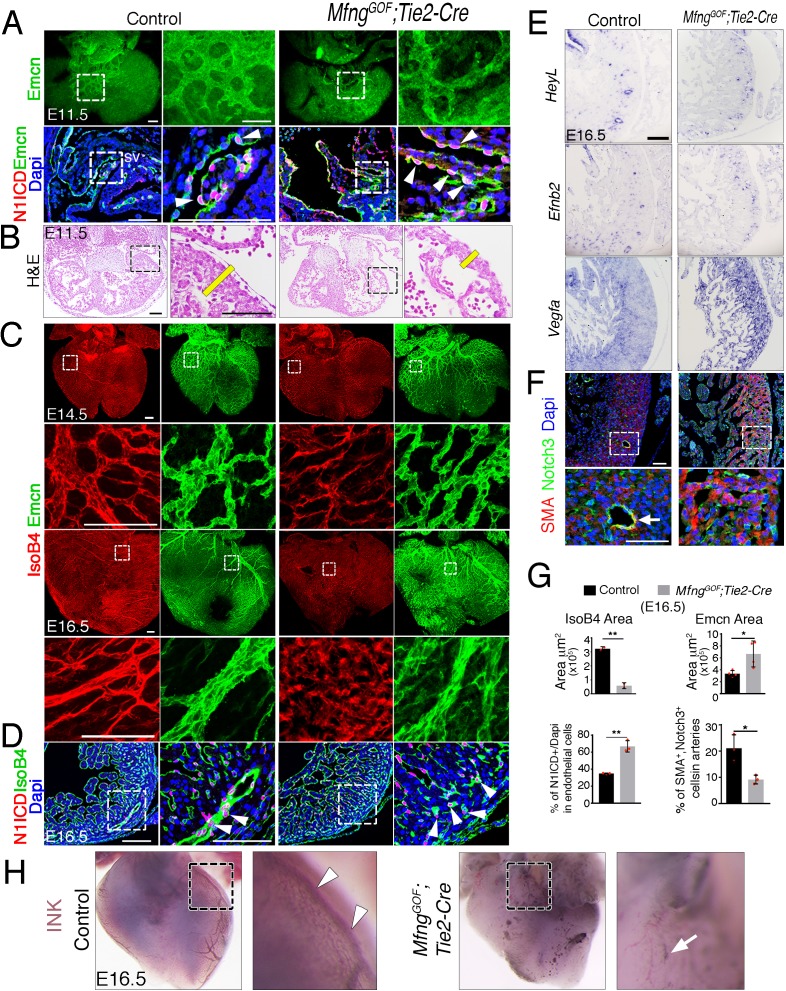
Forced Mfng expression disrupts arterio-venous differentiation and arterial endothelial integrity.(A) Top, Dorsal view of whole-mount immunochemistry for Emcn (labeling SV endothelium, green) in E11.5 control and MfngGOF;Tie2-Cre hearts. Bottom, Immunohistochemistry for N1ICD (red) and Emcn (green) on E11.5 control and MfngGOF;Tie2-Cre heart sections. Dapi counterstain (blue). Arrowheads indicate N1ICD-stained nuclei. sv, sinus venosus. Scale bars, 100 μm. (B) H & E staining of E11.5 control and MfngGOF;Tie2-Cre heart sectionas showing reduced compact myocardium (CM) thickness in transgenic embryo (yellow bar). Scale bars, 100 μm. (C) Dorsal view of whole-mount immunohistochemistry for IsoB4 (red), labeling arteries and Emcn (green), labeling veins and capillaries, in E14.5 and E16.5 control and MfngGOF;Tie2-Cre hearts. Scale bars, 100 μm. (D) Immunohistochemistry for N1ICD (red) and IsoB4 (green) on E16.5 WT and MfngGOF;Tie2-Cre heart sections. Arrowheads indicate N1ICD-stained nuclei. Scale bars, 100 μm. (E) ISH of HeyL, Efnb2, and Vegfa on E16.5 control and MfngGOF;Tie2-Cre heart sections. Scale bar, 100 μm. (F) Immunohistochemistry for SMA (red) and Notch3 (green) on E16.5 control and MfngGOF;Tie2-Cre heart sections. Dapi counterstain (blue). The arrow indicates SMA-Notch3 co-immunostaining in coronary vessels. Scale bar, 50 μm. Microscope: Nikon A1-R. Software: NIS Elements AR 4.30.02. Build 1053 LO, 64 bits. Objectives: Plan Apo VC 20x/0,75 DIC N2 dry; Plan Fluor 40x/1,3 Oil DIC H N2 Oil. (G) Quantified data for E16.5 control and MfngGOF;Tie2-Cre hearts: area covered by coronary arteries (IsoB4-positive vessels). Data are mean ± s.d. (n = 2 control embryos and 2 mutant embryos); area covered by veins (Emcn-positive vessels). Data are mean ± s.d. (n = 4 control embryos and 4 mutant embryos); percentage of N1ICD-positive nuclei in endothelium as a percentage (%) of total nuclei; and SMA-Notch3-co-immunostaining in coronary arteries. Data are mean ±s.d. (n = 3 sections from 3 control embryos and n = 3 from 3 transgenic embryos). *p<0.05, **p<0.01 by Student’s t-test. (H) Visualization of the coronary arterial vasculature at E16.5. Whole–mount aortic ink perfusion of the left coronary artery in control and MfngGOF;Tie2-Cre hearts. Note normal artery perfusion in the control (arrowheads) and the interrupted hemorrhaging artery in the transgenic heart (arrow).